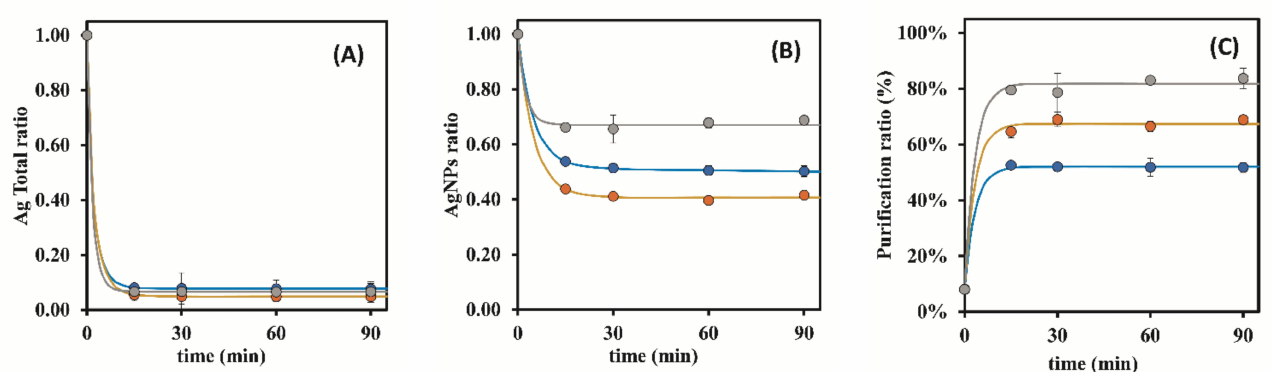
Figure 5. The influence of the resin mass (Bio-Rad 50W-X8 100–200 mesh) on the removal ratio of the Ag + present in suspension over time ( • —0.25 g of resin; • —0.50 g of resin; • —1.00 g of resin): ( A )—Ag total ratio in the suspension; ( B )—AgNPs ratio in the suspension; ( C )—Purification ratio (%). The represented values are the average of 3 replicates for each different